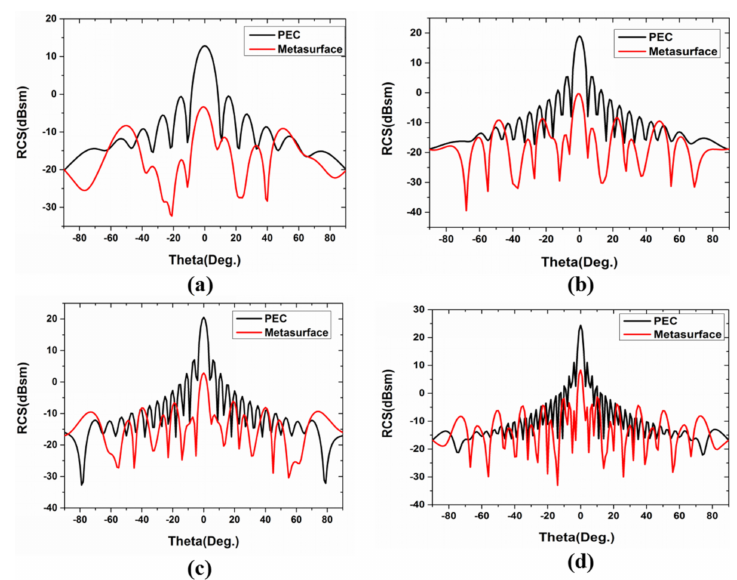
Figure 9. Two-dimensional scattering patterns for ( a ) 7.2 GHz, ( b ) 14.6 GHz, ( c ) 17.2 GHz, and ( d ) 27.6 GHz of metasurface and PEC surface.